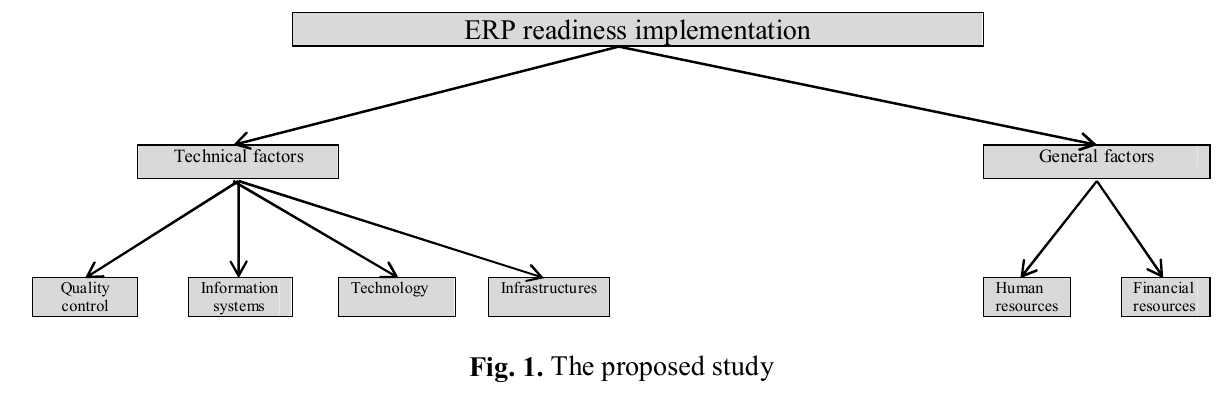
Fig. 1. The proposed study